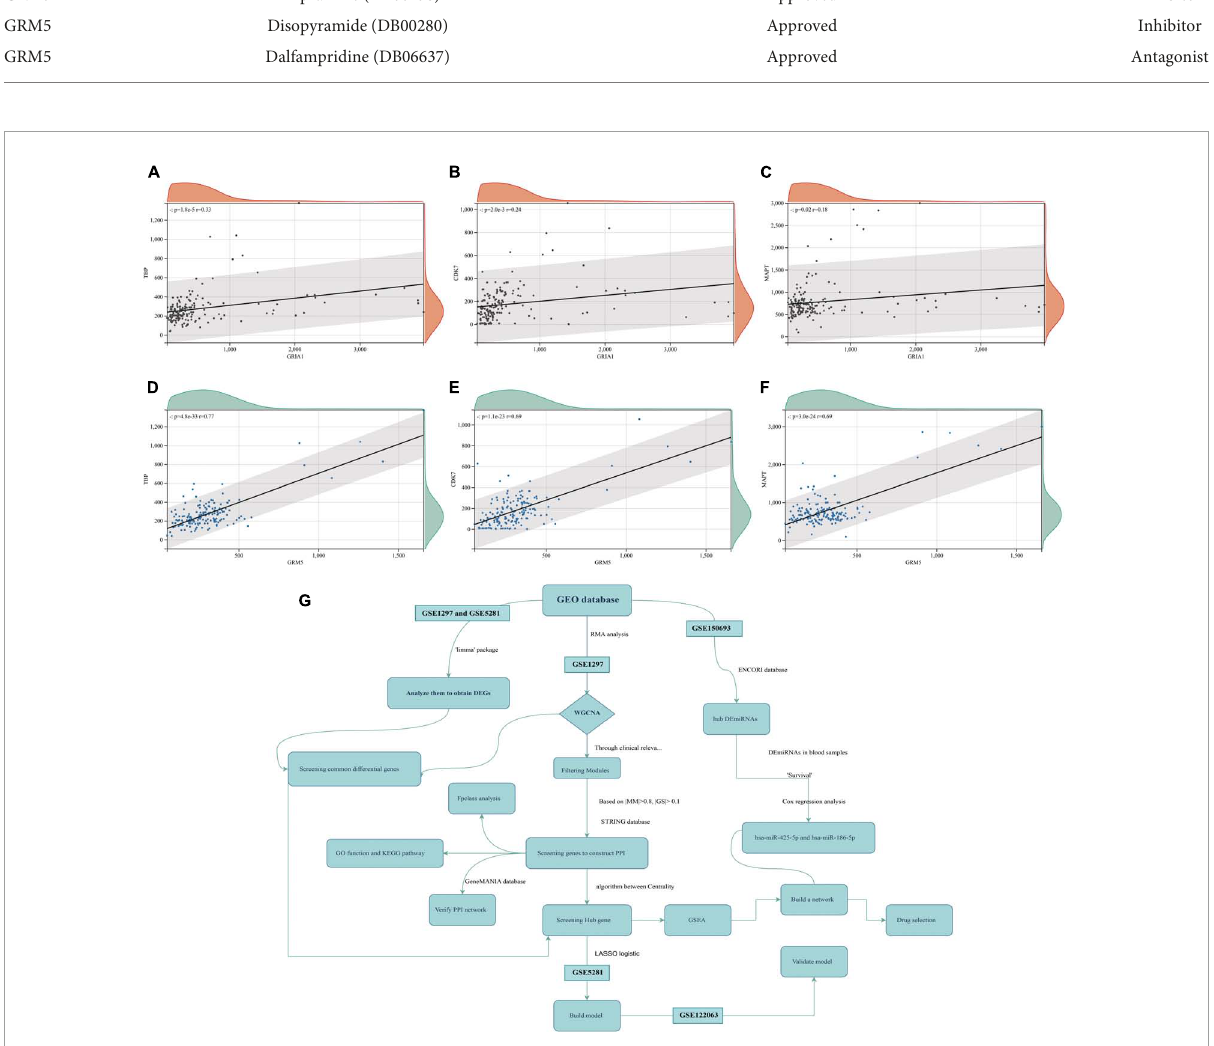
FIGURE9 Protein-to-protein correlation graph (GSE5281 data set). (A–C) Respectively, the correlation map of GRIA1 and TBP, CDK7, MAPT. (D–F) Respectively, the correlation map of GRM5 and TBP, CDK7, MAPT. (G) The flow-process